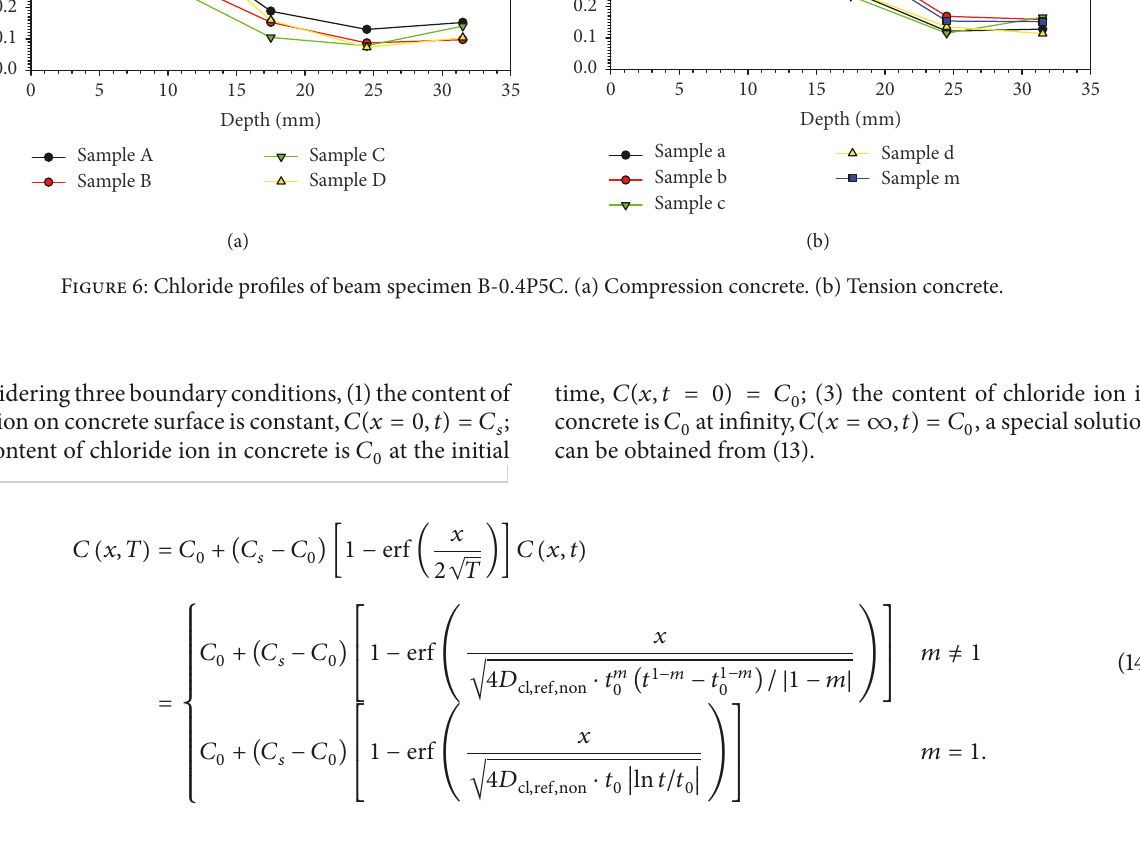
Figure 6: Chloride profiles of beam specimen B-0.4P5C. (a) Compression concrete. (b) Tension concrete.